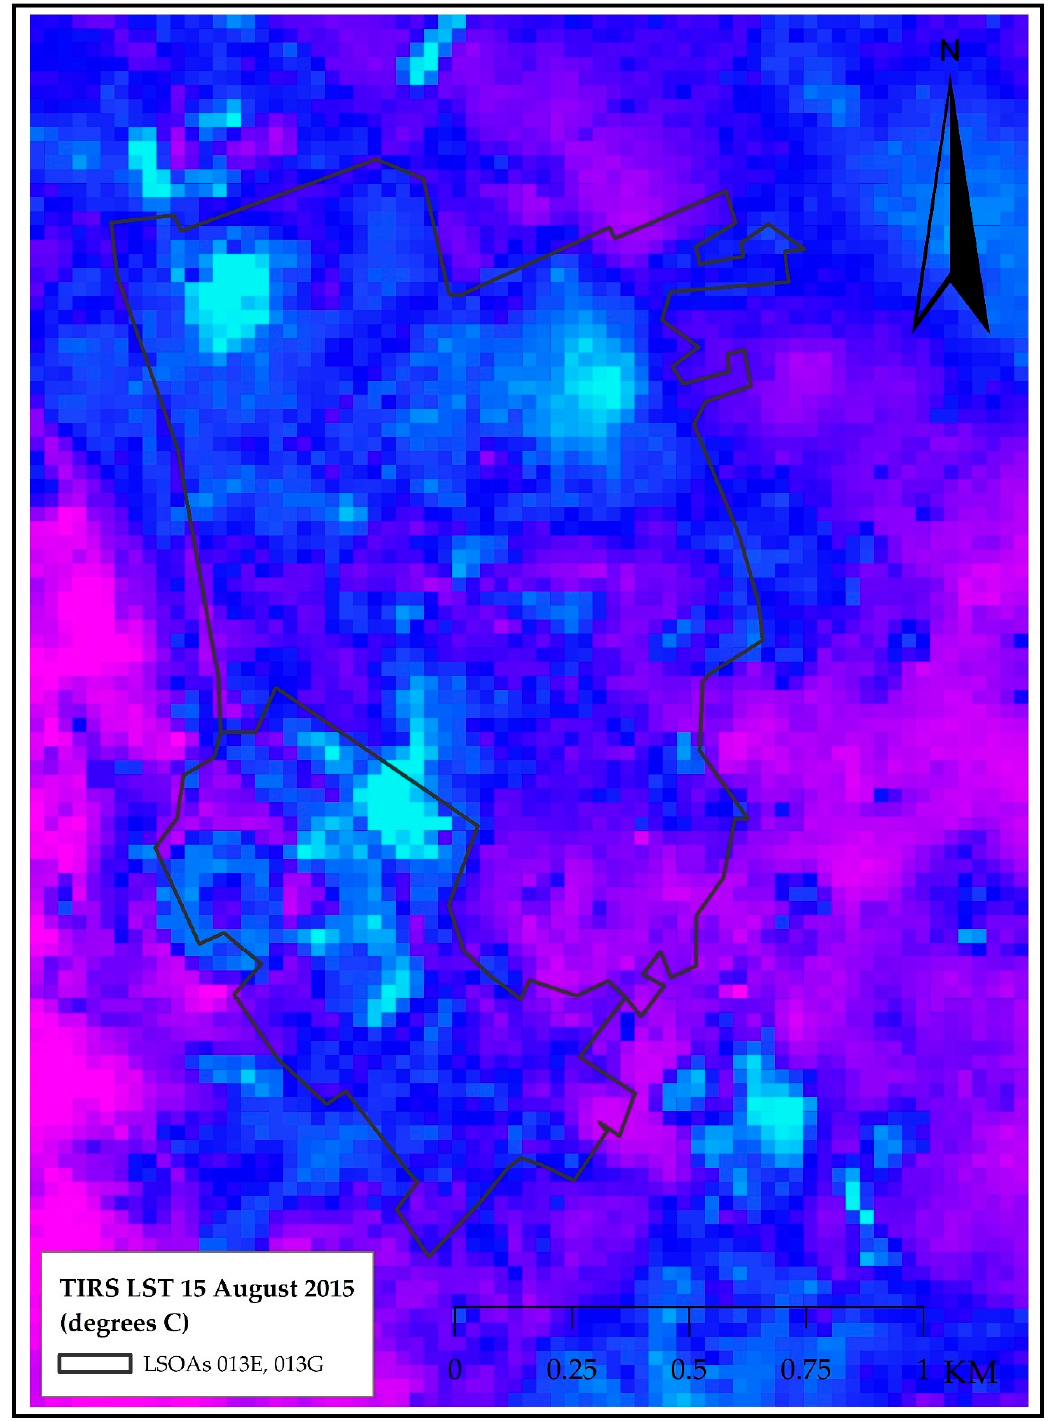
Figure 9. Land surface temperature development over the area of Stratford London (LSOAs 013E, 013G), as calculated from LANDSAT 8 OLI/TIRS imagery acquired at 10:58 a.m. U.T. on 15 August 2015. Contains National Statistics data © Crown Copyright and database right (2015) and (2012). Contains Ordnance Survey data © Crown Copyright and database right (2015) and (2012).